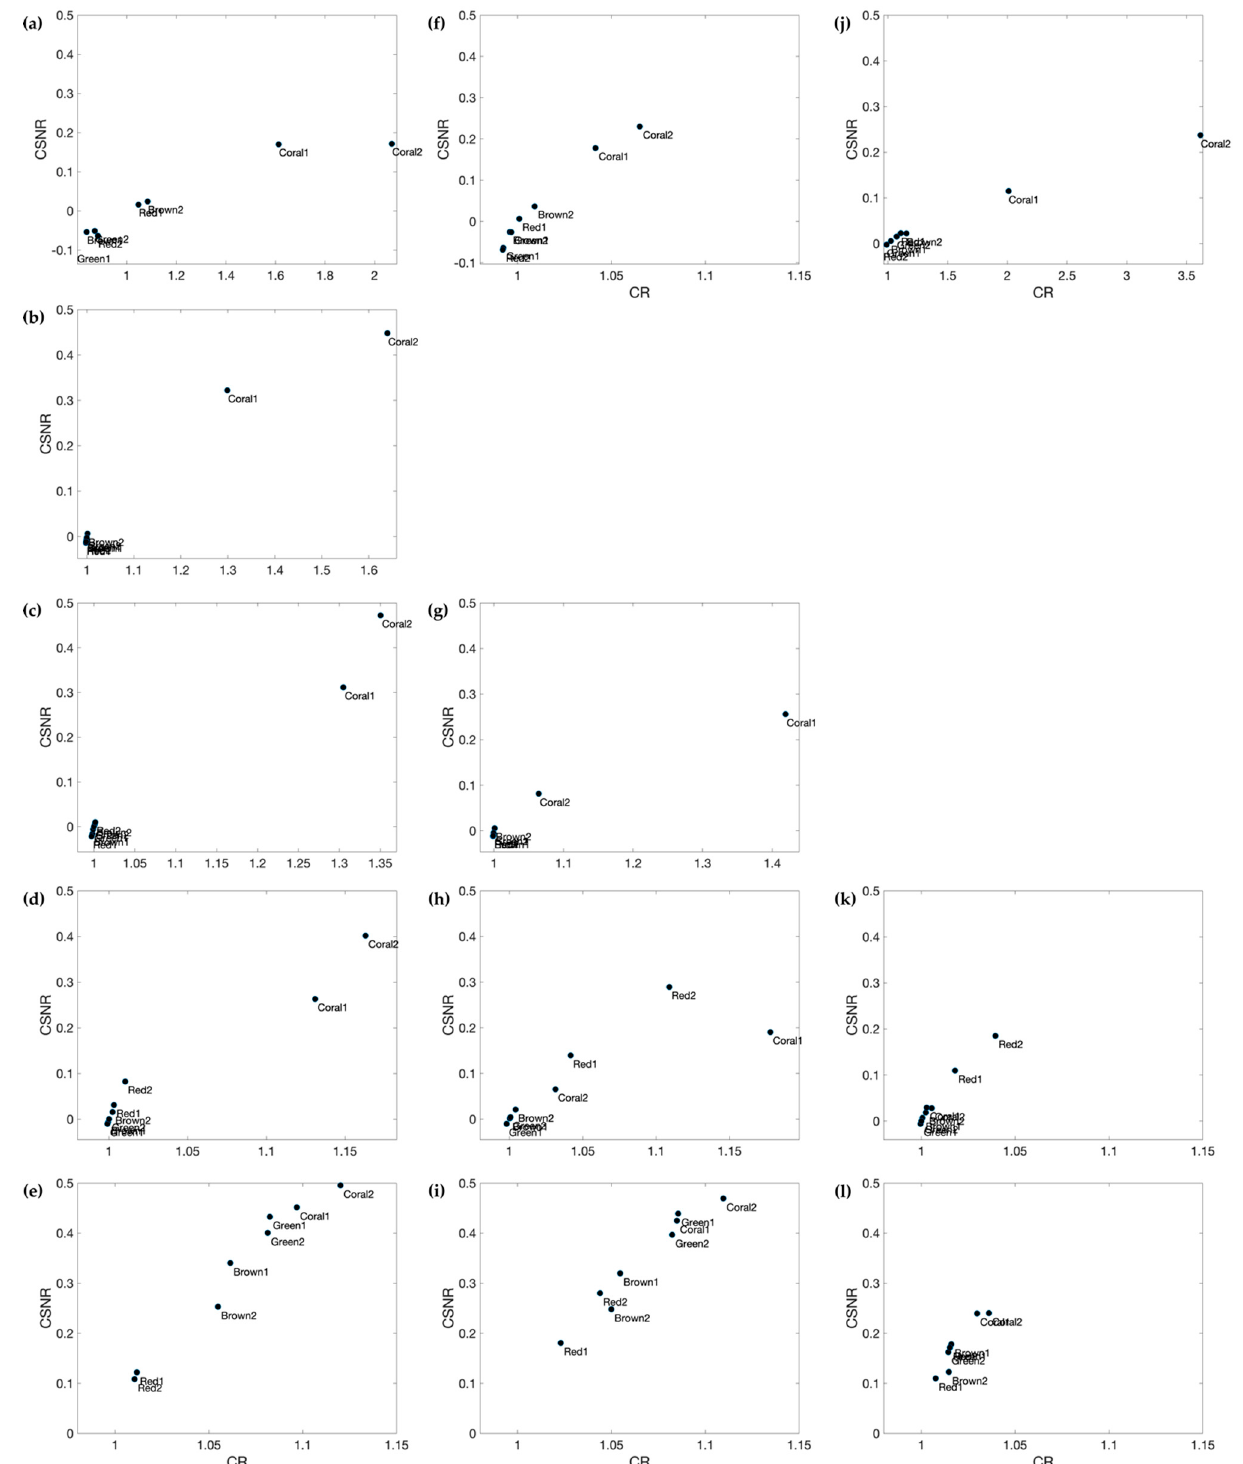
Figure 11. Contrast Signal − to − Noise − Ratio (CSNR) and Contrast − Ratio (CR) indices calculated on select spectral response image subsets of macroalgae and coral specimens, from excitation at 450 nm (left column), from top to bottom with ( a ) reflectance at 450 nm with bandpass filter, and emission at ( b ) 490, ( c ) 520, ( d ) 580, and ( e ) 685 nm; excitation at 490 nm (middle column), from at top to bottom with ( f ) reflectance at 490 nm with bandpass filter, and emission at ( g ) 520, ( h ) 580, and ( i ) 685 nm, and excitation at 520 nm (right column), from top to bottom with ( j ) reflectance at 520 nm with bandpass filter, and emission at ( k ) 580 and ( l ) 685 nm.